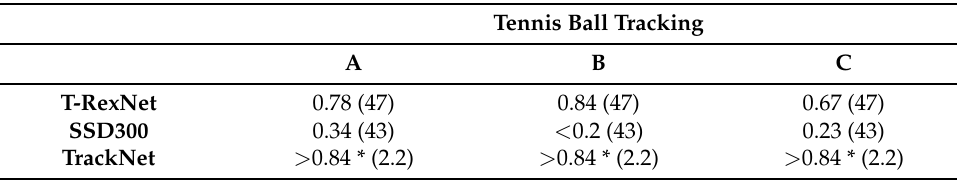
Table 5. Comparison of F1 scores achieved in the Tennis ball tracking scenario. Numbers in brackets represent the measured speed, in frames per second, with the Desktop platform. This scenario is splitted into the three videos we considered, with different camera view, court and environment. The asterisk indicates that the number is retrieved from the original